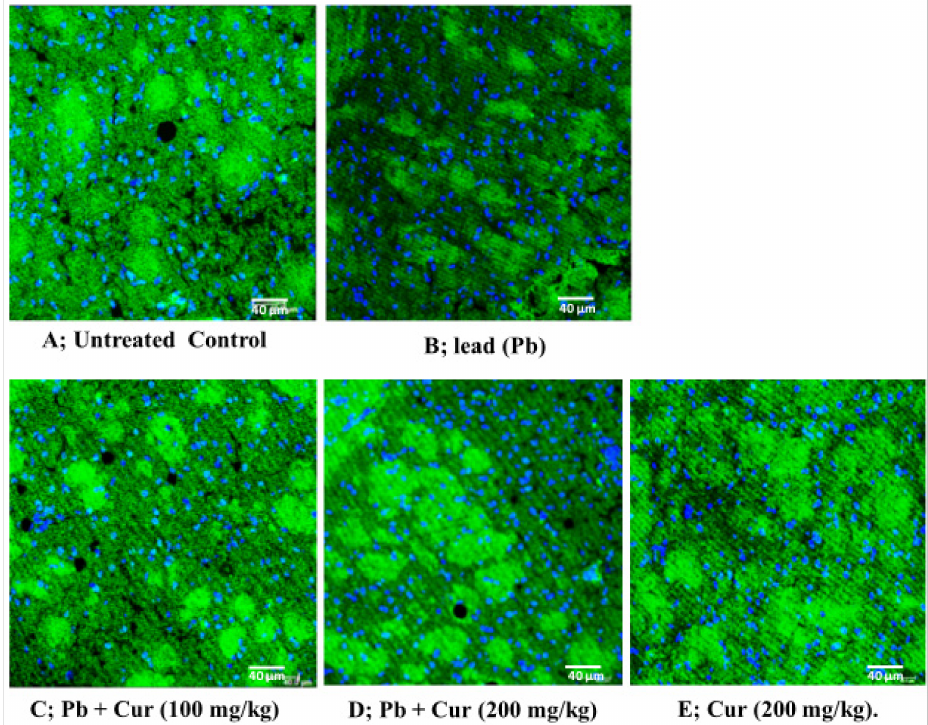
Figure 4. Immunohistochemistry—effect of curcumin on the acetylcholinesterase (AChE) expression